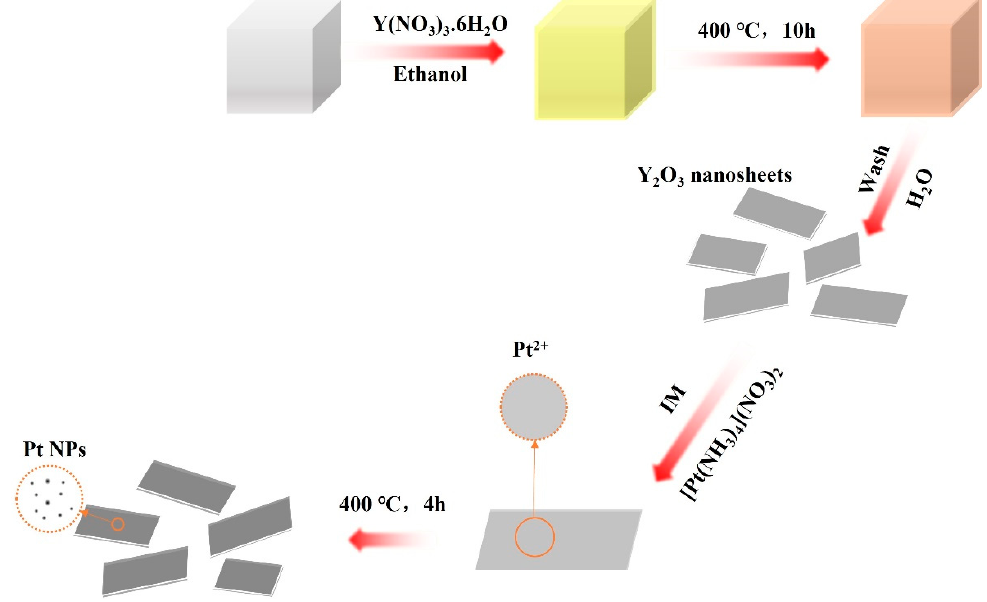
Figure 1. Schematic illustration for preparation of a Pt/Y 2 O 3 -NaCl sample.